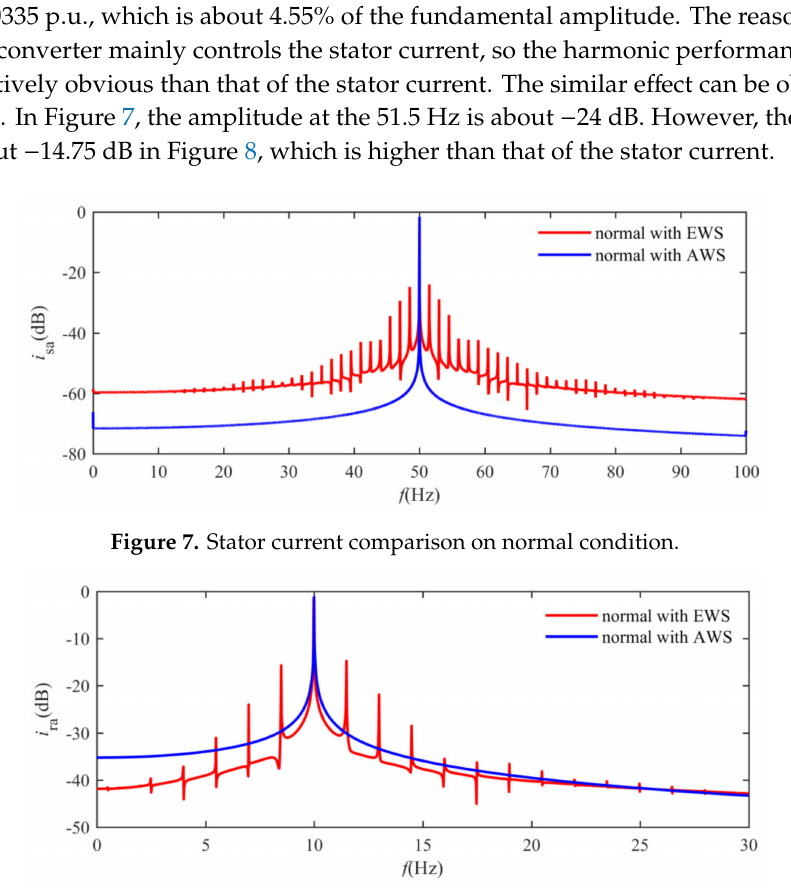
Figure 8. Rotor current comparison on normal